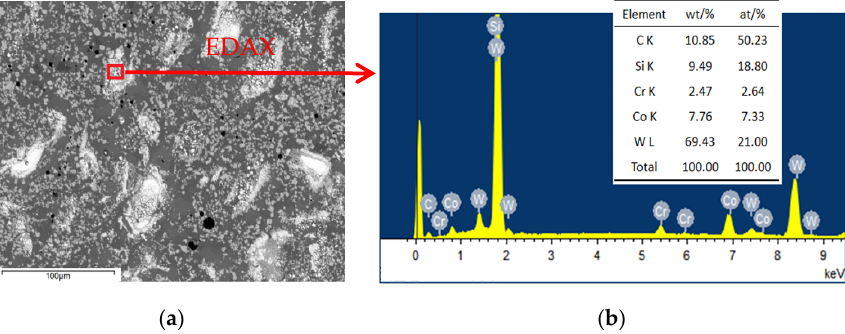
Figure 10. EDAX results of surface layer, ( a ) Coating scanning, ( b ) Particle enhanced EDAX results.